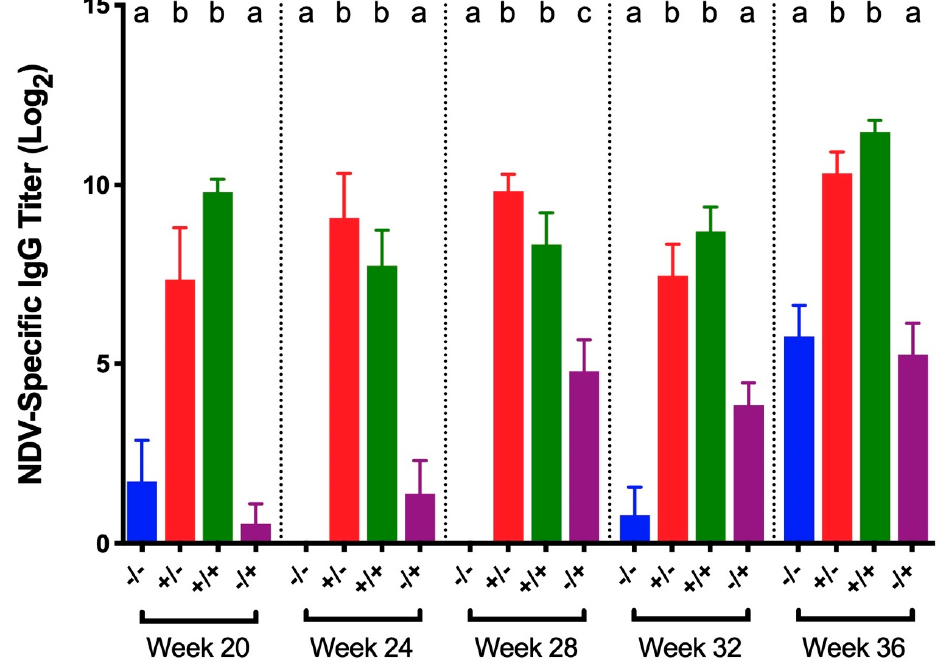
Figure 4. NDV-specific IgG titers in serum collected 5 days post-challenge with NDV B1 vaccine for different groups of birds challenged at 20, 24, 28, 32, and 36 WOA. Letters (a–c) indicate significant differences among vaccine and challenge groups for each week ( p < 0.05). − / − = non-vaccinated/non-challenged, +/ − = vaccinated/non-challenged, +/+ = vaccinated/challenged, − /+ = non-vaccinated/challenged.